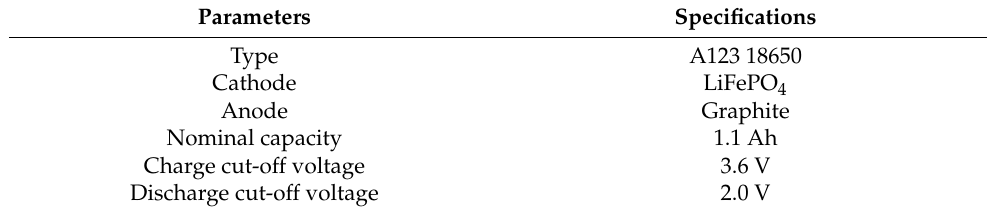
Table 1. Specifications of the batteries.